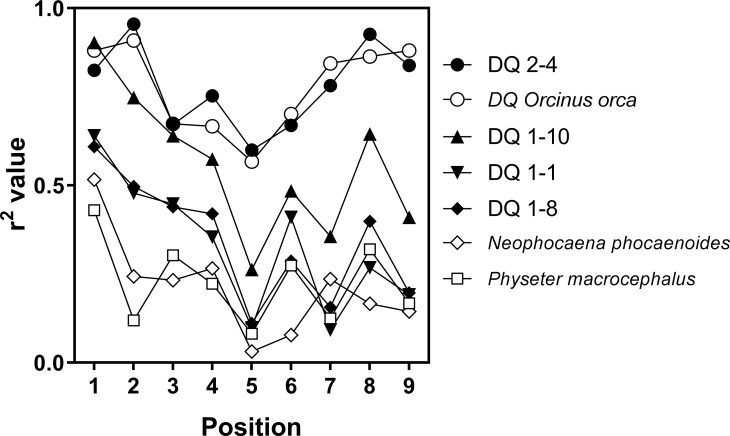
Comparison of rankings for dolphin (standard) to four IRL dolphins and 3 other cetaceans.Correlations were performed on scatterplots of amino acid ranking obtained from our standard DQ protein of Bottlenose dolphin (Tursiops truncatus), with each of the four proteins found in the IRL (DQ1-1, DQA 1–8, DQA1-10 and DQ2-4). Correlations were also performed comparing the amino acid ranking from DQ proteins for standard bottlenose dolphin to those of killer whale (Orcinus orca), Yangtze finless porpoise (Neophocaena phocaenoides) and sperm whale (Physeter microcephalus). Coefficients of determination (r2) derived from Pearson coefficients (r) are plotted for each of the 9 positions of the MPSLs.